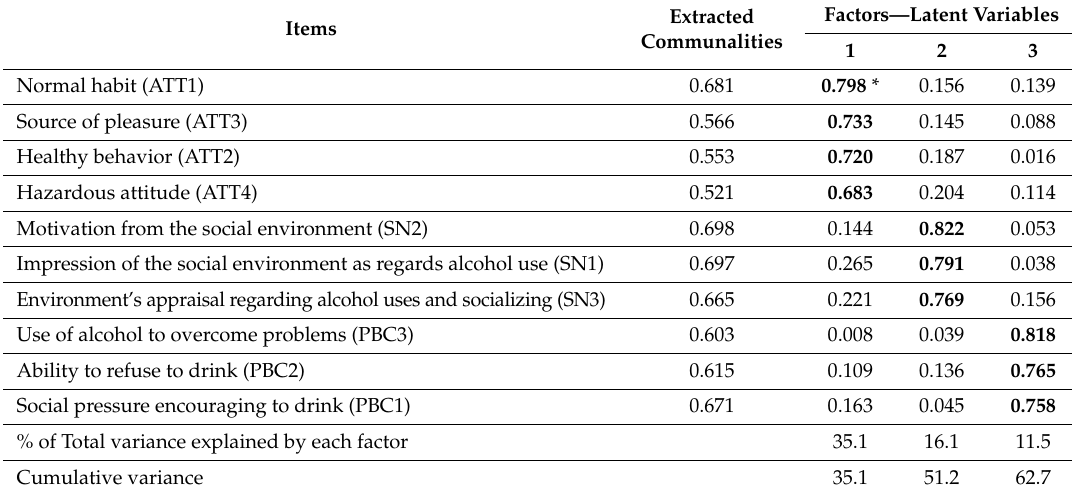
Table 2. Exploratory factor